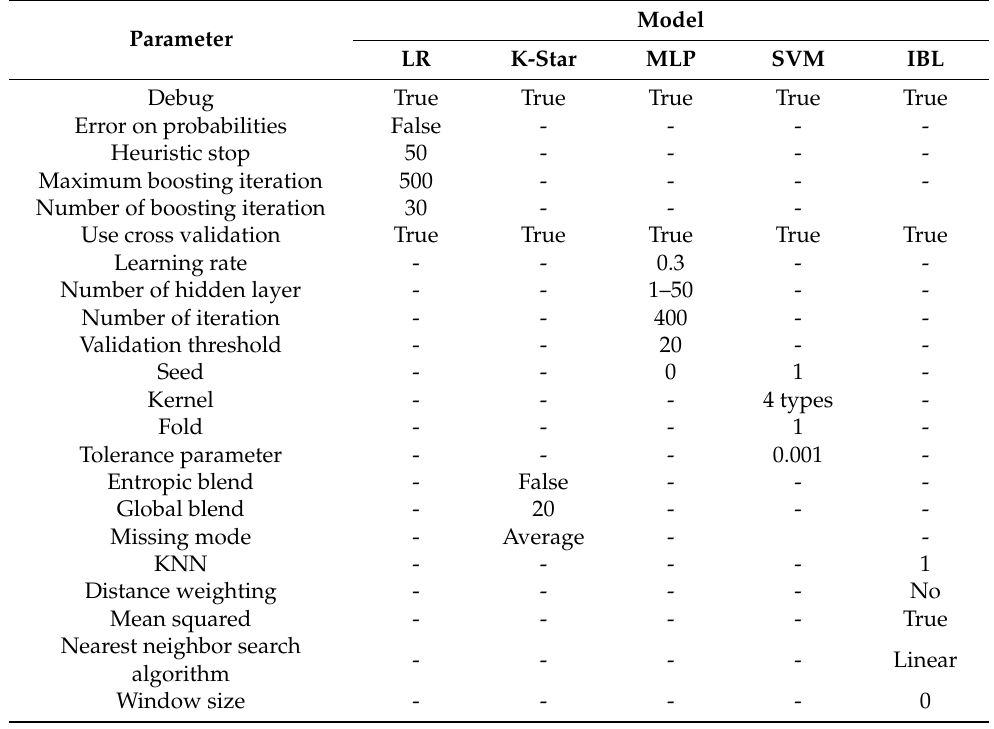
Table 1. Optimum parameter setting of the